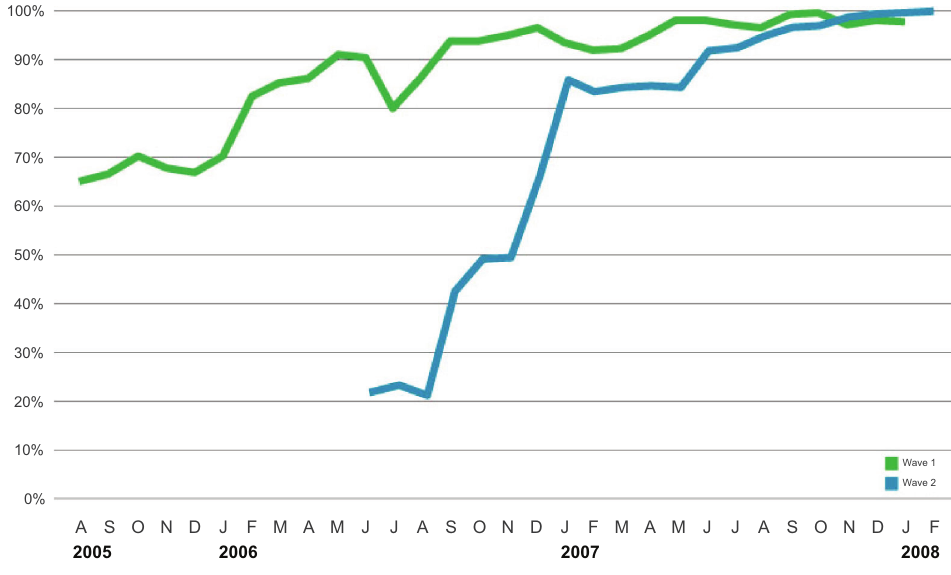
Figure 6. Uganda: compliance with criteria for screening for active TB in HIV-positive patients. The rate of adoption of screening for TB in HIV patients was much faster in wave 2 than wave 1.